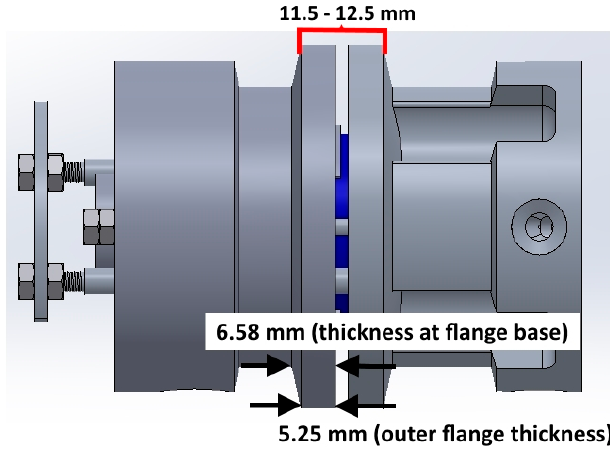
Figure 7. Quick-release flange system (assembled).